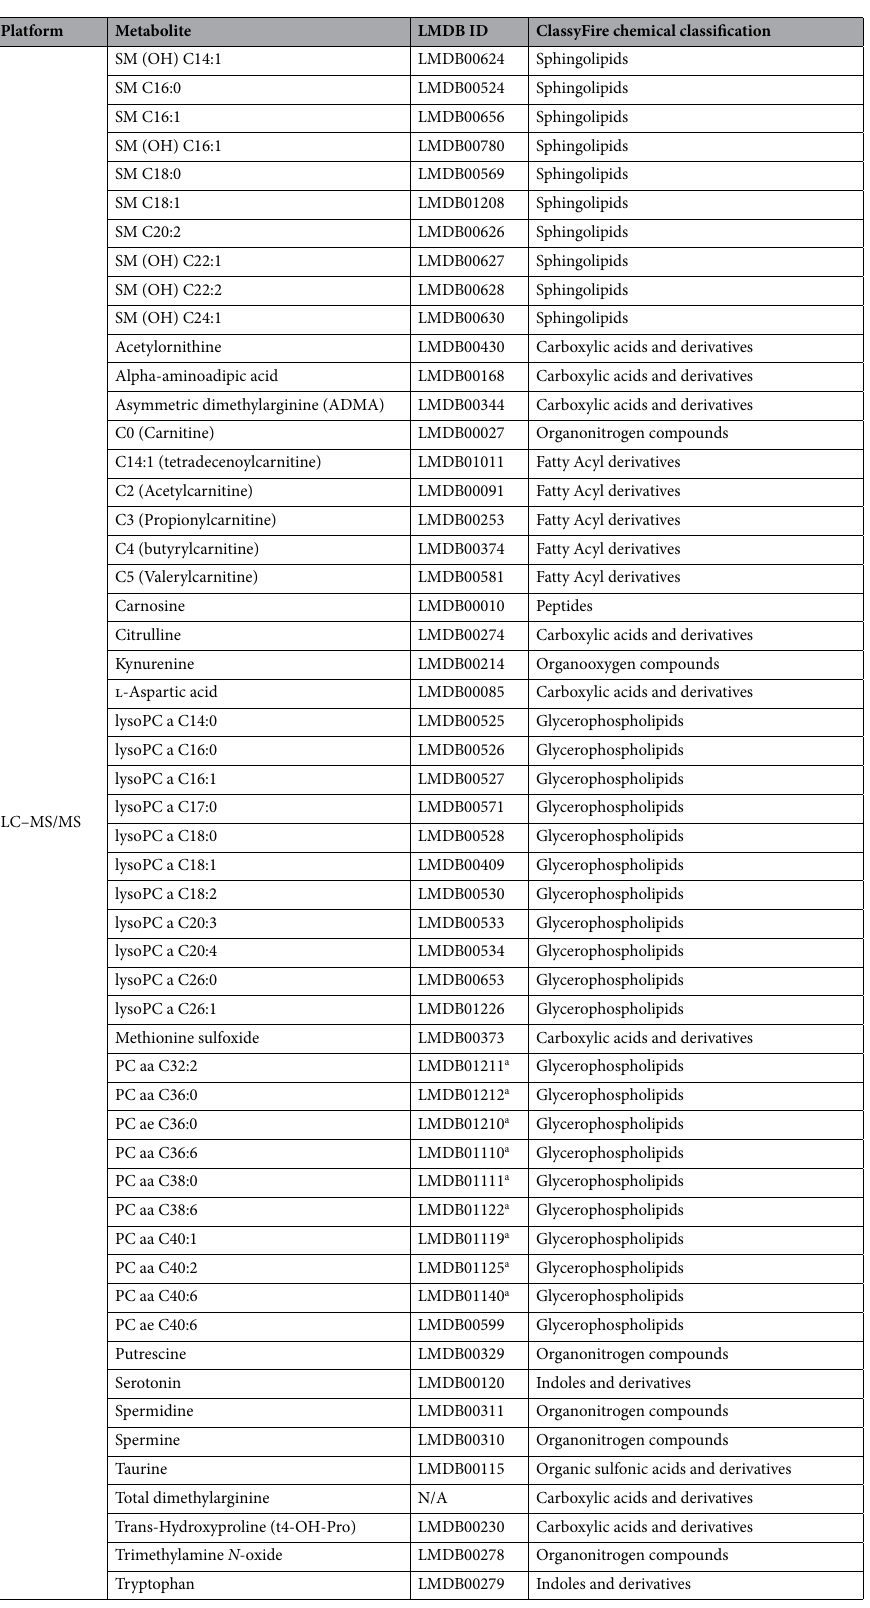
Table 1. Serum metabolome associated with sheep pregnancy. Metabolites include those identified and quantified by NMR and LC–MS/MS from serum of healthy sheep assessed for pregnancy and litter size. Metabolite IDs identified by a Refer to an isomer of that lipid. Note that total dimethylarginine does not have a LMDB ID since it consists of the sum of two metabolites (symmetrical and asymmetric